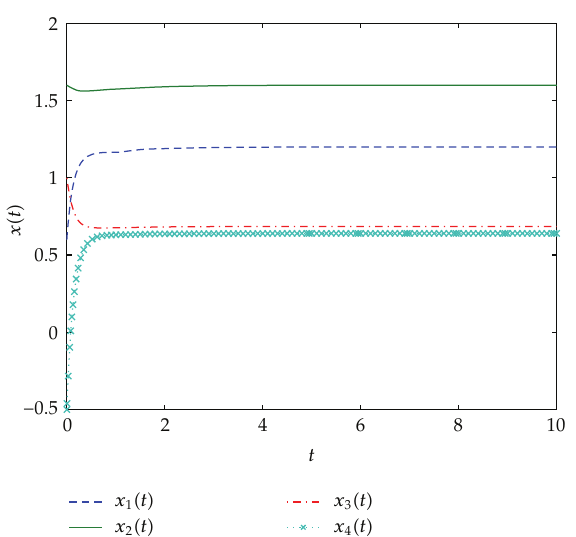
Figure 2: Time responses of the state variables x (cid:4) t (cid:7) with initial value φ (cid:4) s (cid:7) (cid:8) (cid:4) 0 . 6 , 1 . 6 , 1 , − 0 . 5 (cid:7) T for s ∈ (cid:5) − 1 , 0 (cid:6) in Example